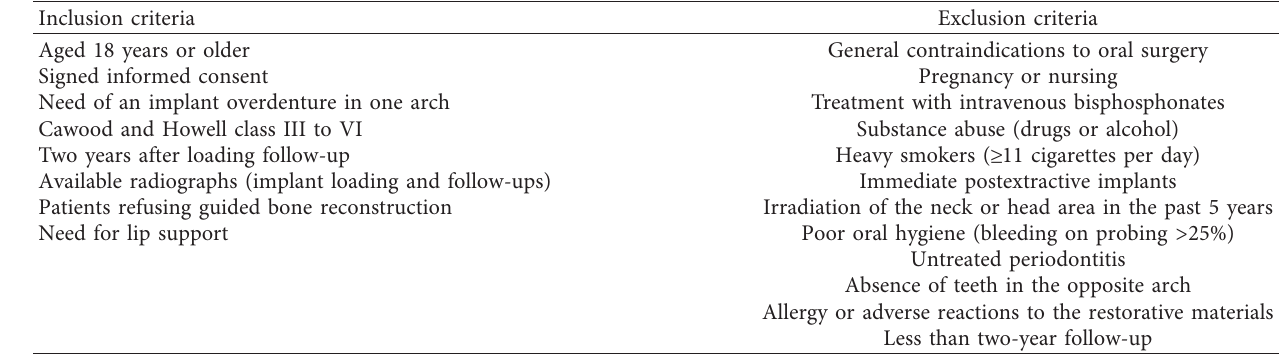
Table 1: Inclusion and exclusion